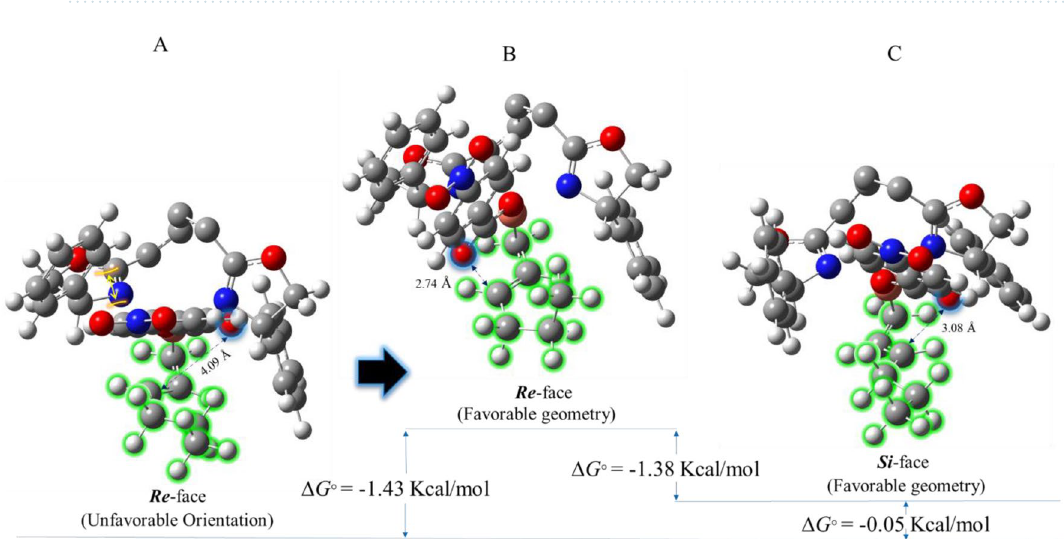
Figure 8. Geometries and Gibbs free energies of the Si -face and Re -face of the key reaction intermediate containing 1-hexene reactant. To better visibility, some atoms of biphenyl backbone are not